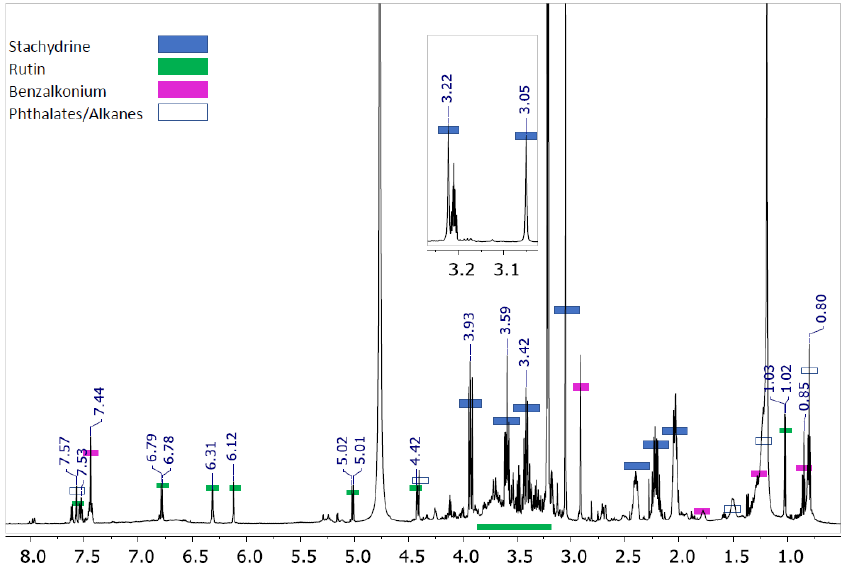
Figure 2. 1 H NMR (nuclear magnetic resonance) spectra of the most cytotoxic sub-fraction (M8R) in CD 3 OD, isolated from S. spinosum after fractionation and purification. Alkane chain is correlated with aliphatic chain of benzalkonium chain. Phtalate signals—indicate the presence of phtalates in the plastic material used to transfer of the sample for analysis and mainly the use of silicone lubricants on glass